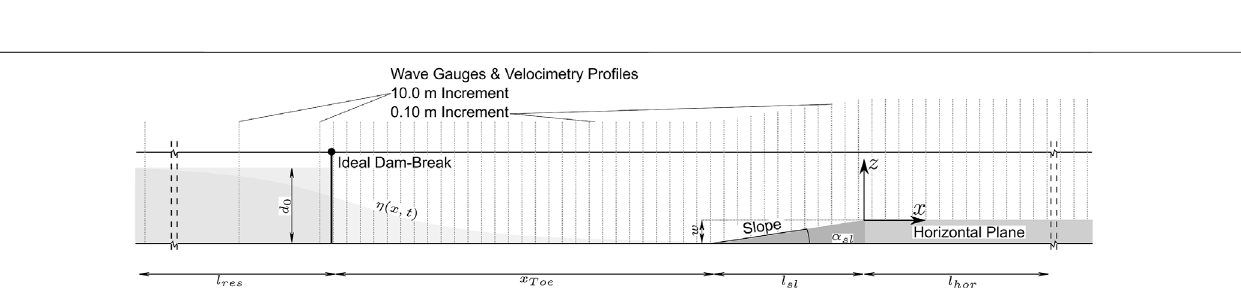
FIGURE4| Numerically calculatedwavegaugetimehistories(SWEandURANSapproach)comparedtolaboratorydata.Flatbottomtestwithinitialimpoundment depth d 0 (cid:1) 0 . 60m( (A – D) ,testno.2,see Table1 ),compositebathymetrywith d 0 (cid:1) 0 . 50m( (E – H) ,testno.3,see Table1 ),andcompositebathymetrywith d 0 (cid:1) 0 . 60m ( (I – L) , test no. 4, see Table 1 ). Deviations between experimental and numerical data are given as MSE in each sub fi gure.